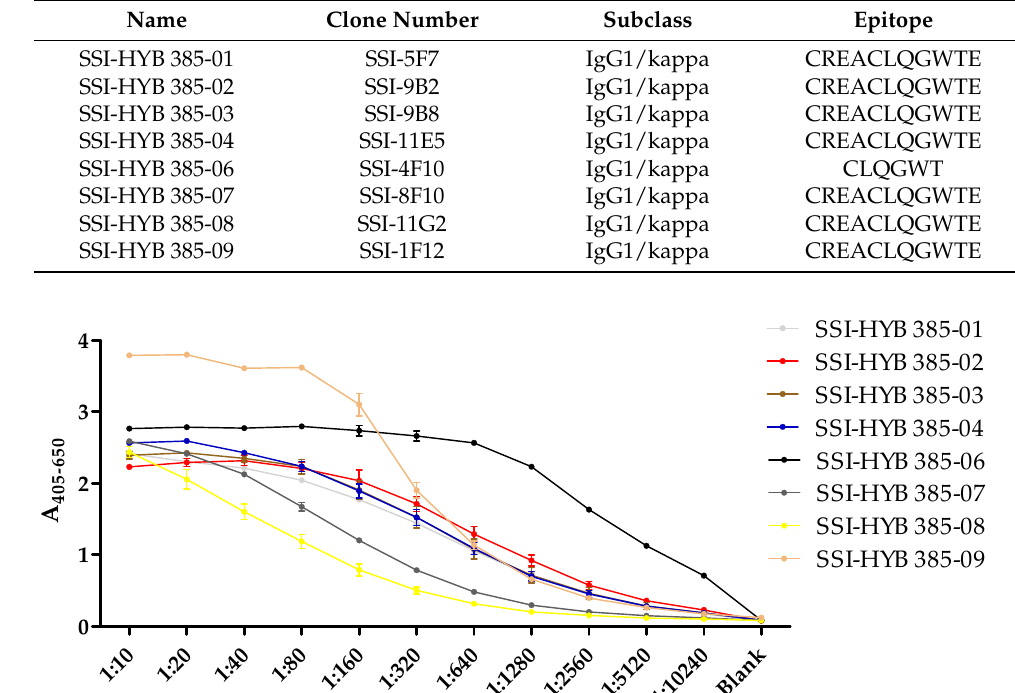
Table 1. Antibody clones selected for final characterization.